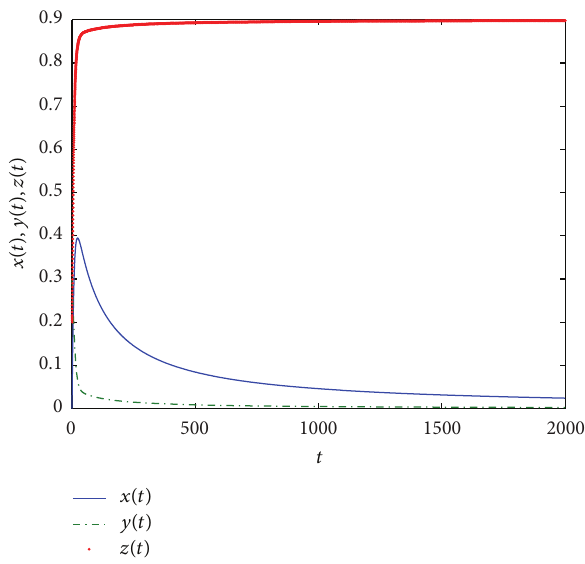
Figure 5: Parameters: 𝛽 = 0.2, 𝛼 = 0.14, 𝛾 = 0.02, 𝜇 = 0.05, 𝜔 = = 0.1, and 𝛿 = 0.5 . 0.05, 𝑐 = 0.1, 𝛿 1 2